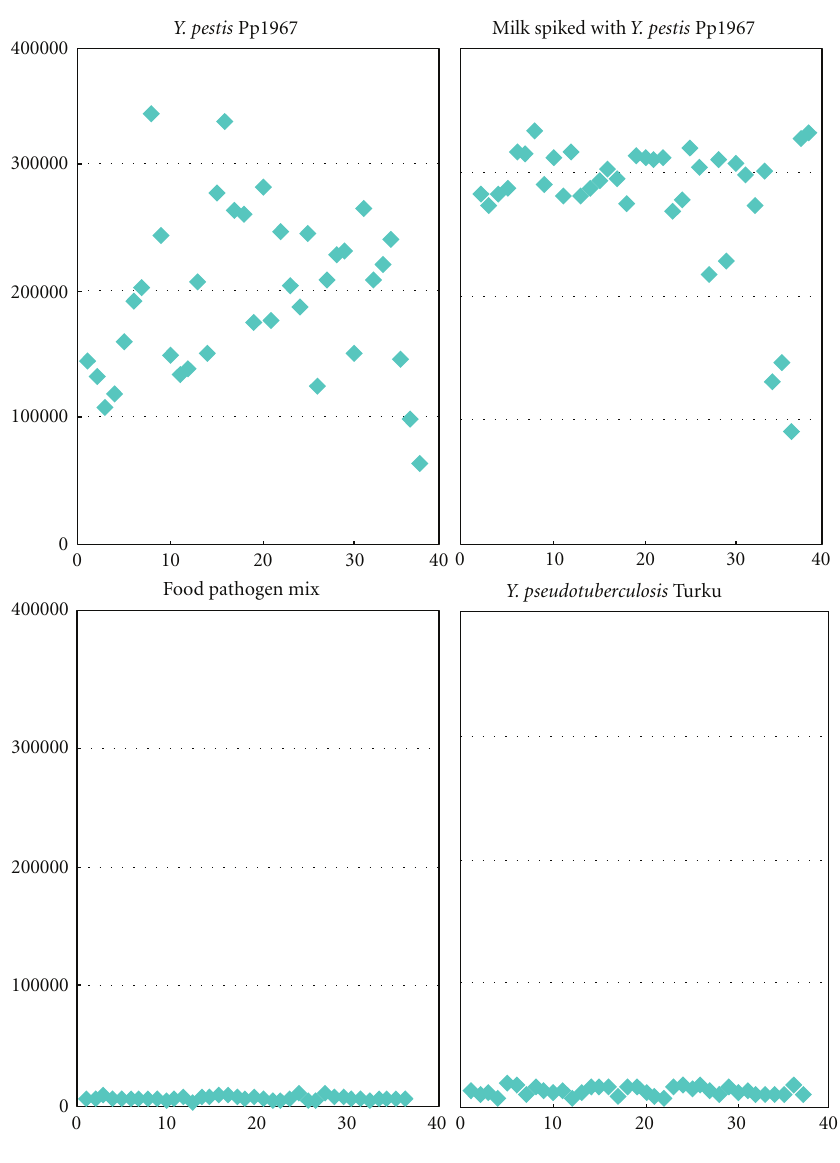
start material for the microarray analysis. This led to the successful simultaneous detection and identification of